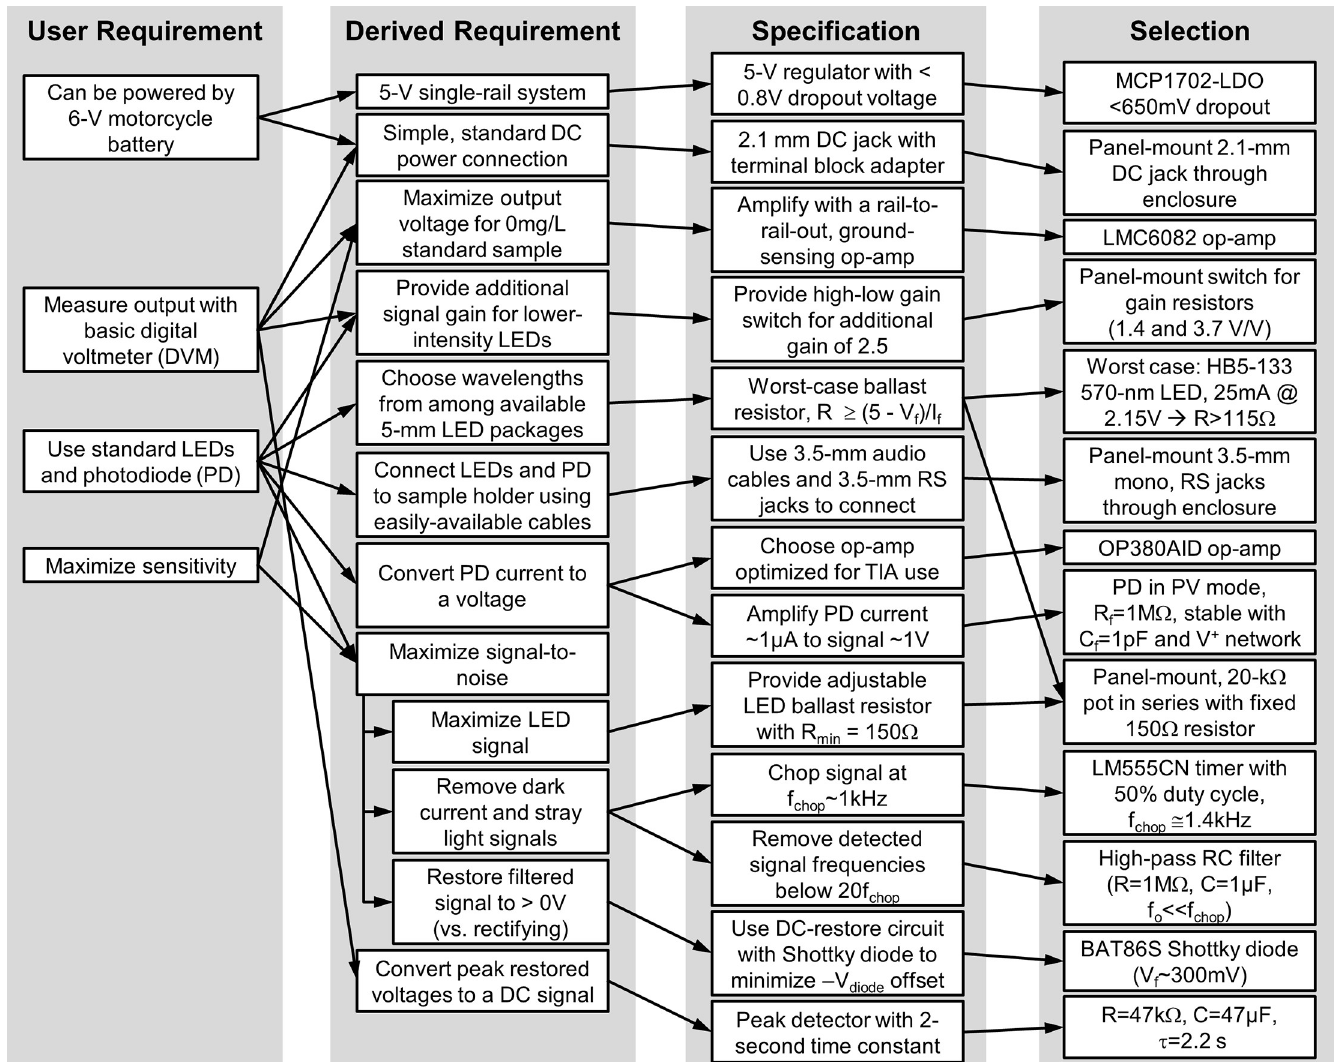
Fig 1. The requirements, specifications, and component selection of the light emitting diode (LED) spectrophotometer.